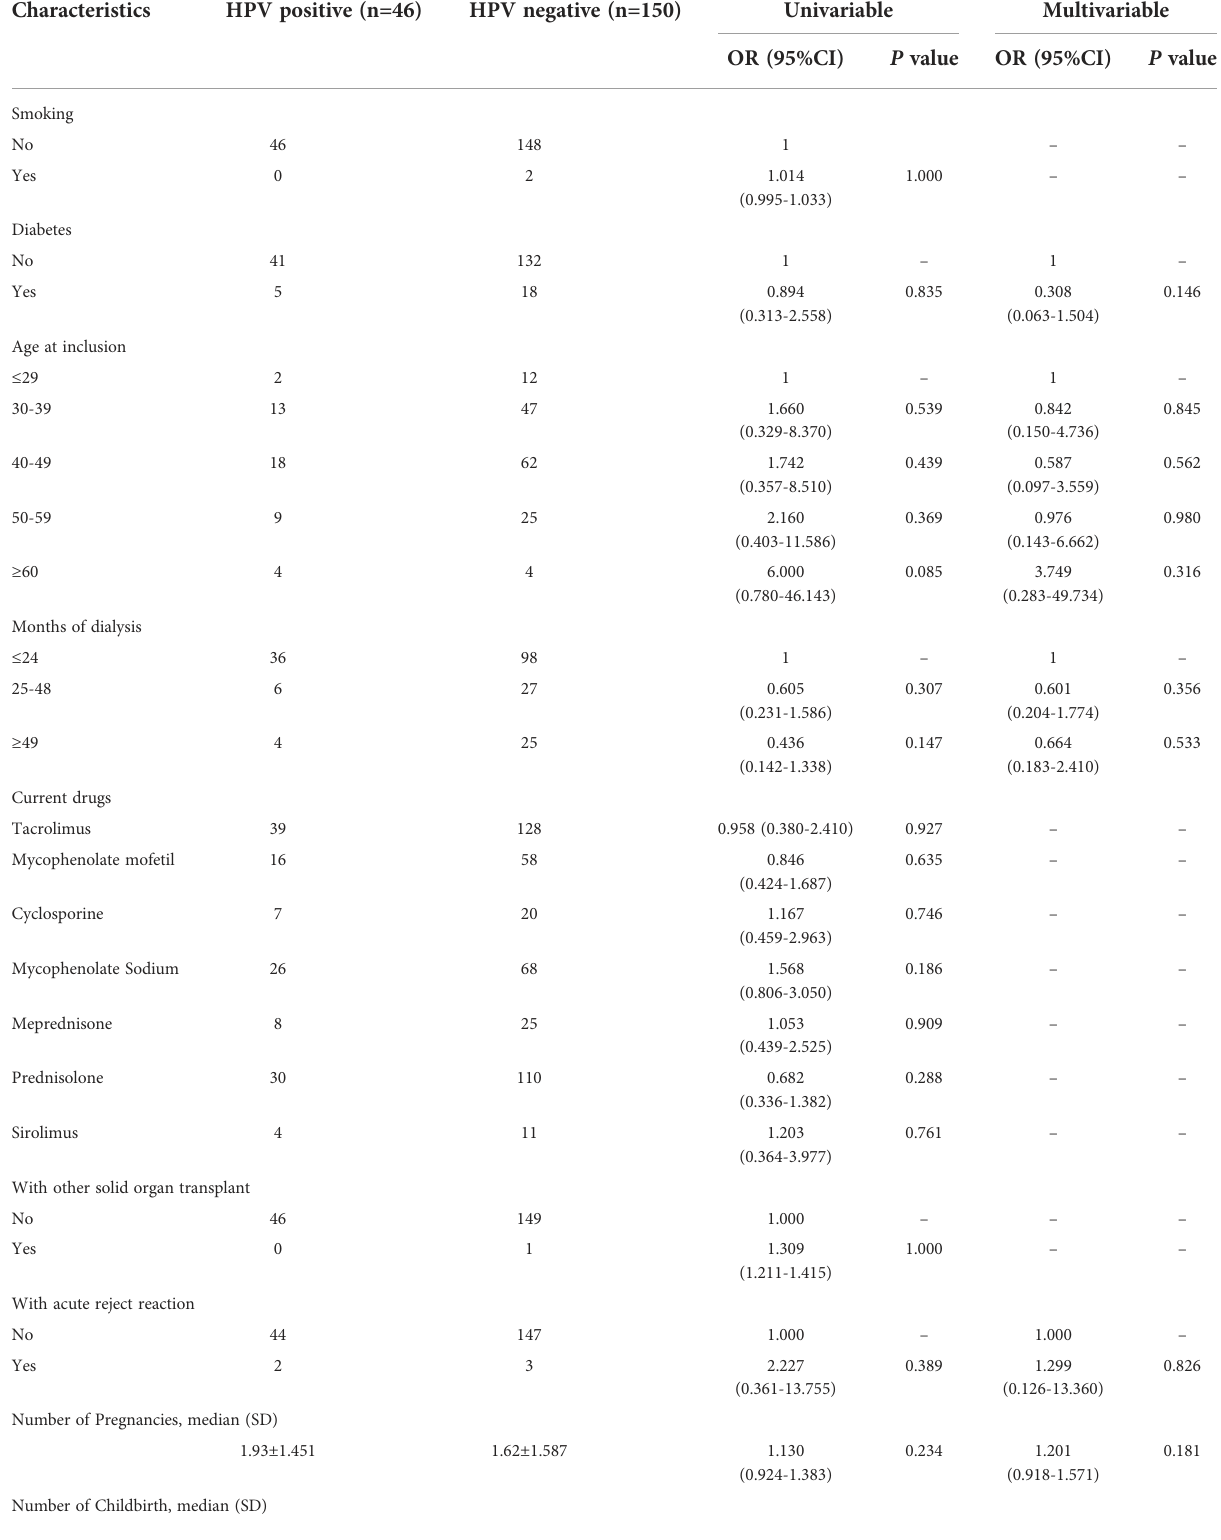
TABLE 3 Univariate and multivariate analysis of risk factors for HPV infection in